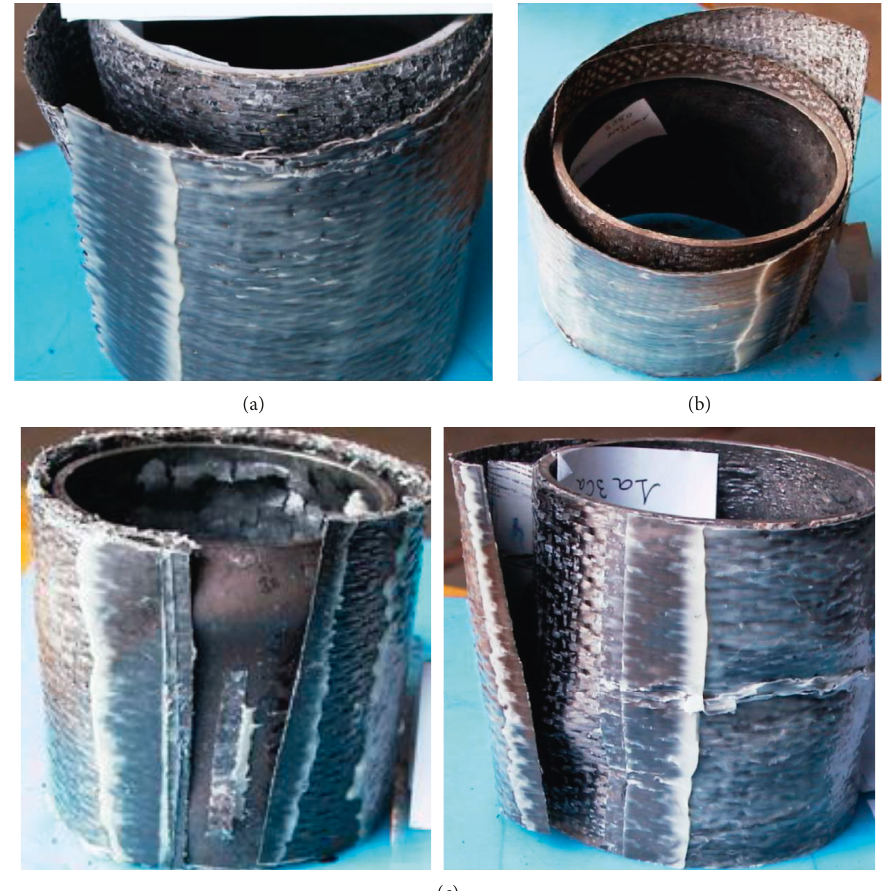
Figure 6: (a) Damage to the steel/composite interface; (b) interlayer delamination due to localized loading on CFRP; (c) null or insufficient covering conducts to inhibit “belt effect” of the CFRP layer.